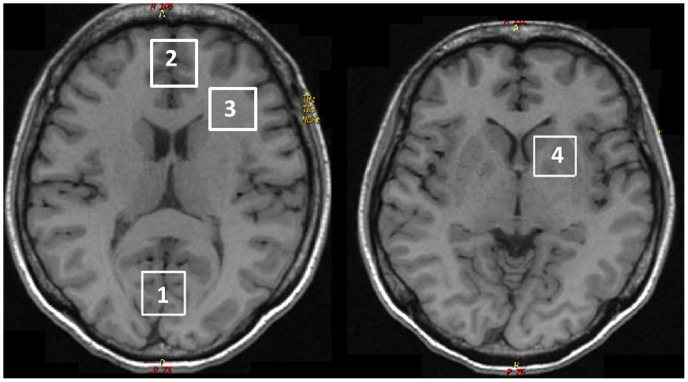
MRS voxel locations (representative examples).1. Occipital grey matter, 2. Frontal grey matter, 3. Frontal white matter, 4. Basal ganglia.